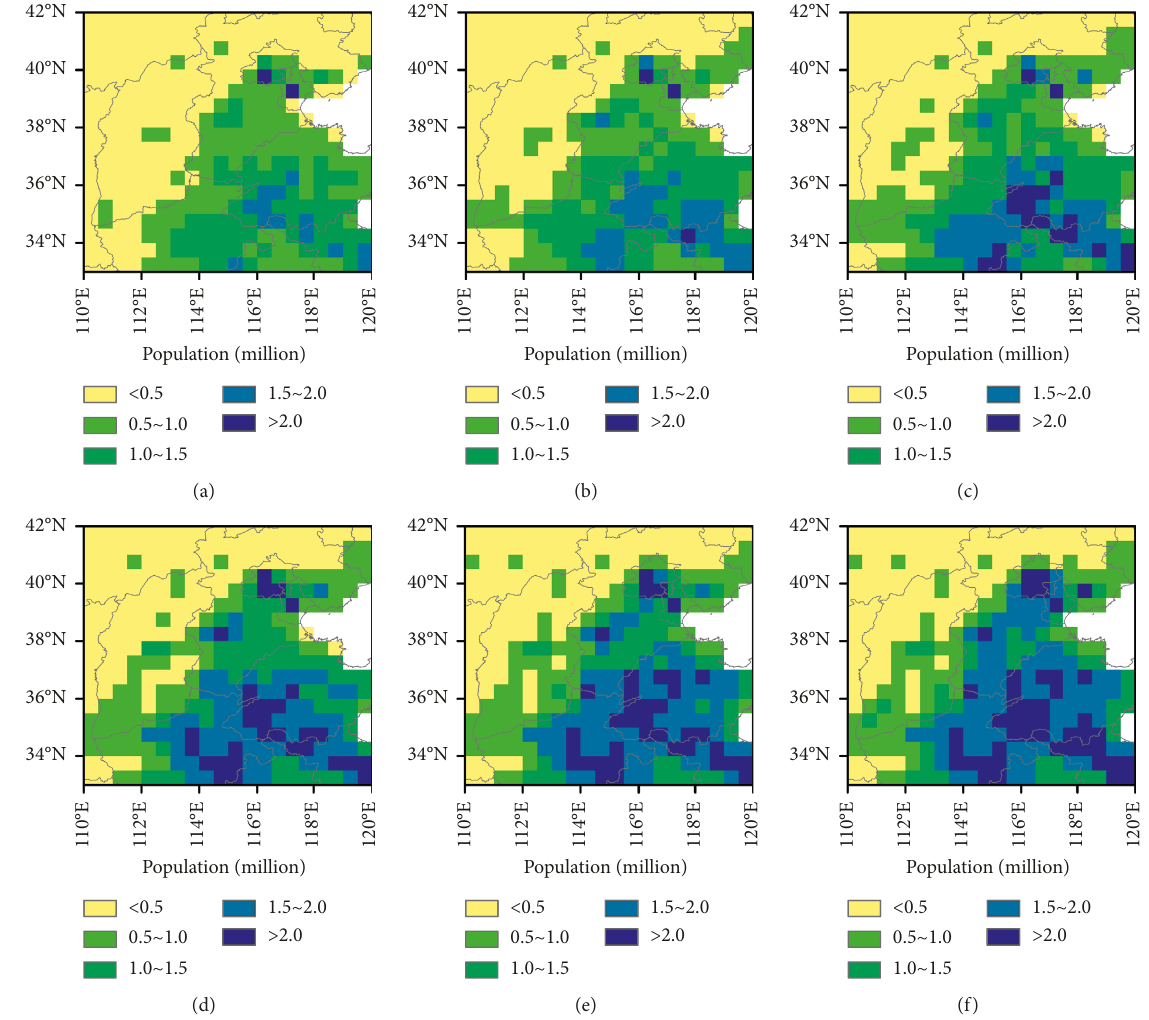
Figure 8: Spatial distribution of population on the North China Plain. (a) 1961–1970, (b) 1971–1980, (c) 1981–1990, (d) 1991–2000, (e) Table 1: Analysis of factors influencing population exposure change to heatwave events on the North China Plain. Exposure